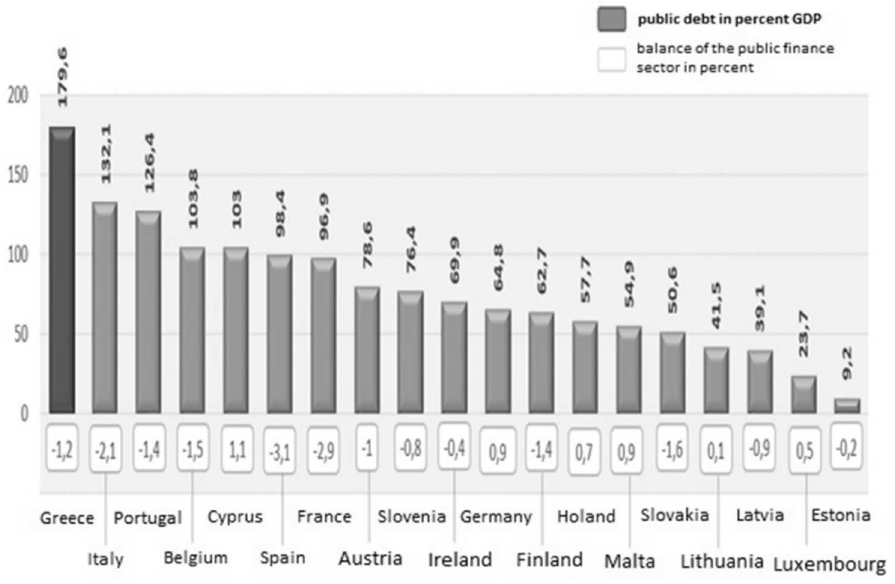
Figure 1. Public debt and the public finance sector balance in 2017